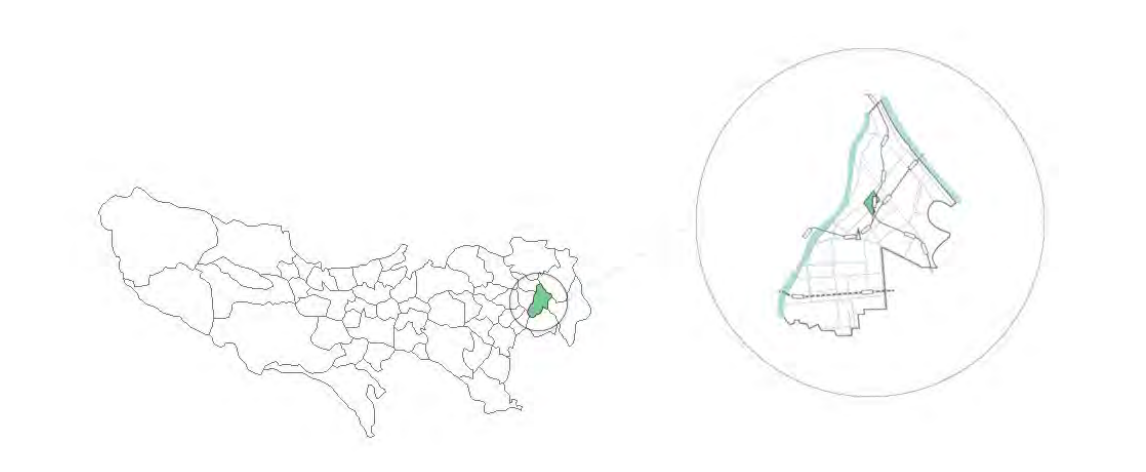
Figure 1. Location of Sumida ward in Tokyo prefecture and of Hikifune neighbourhood within Sumidaward